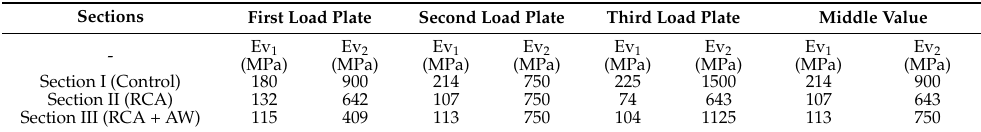
Table 8. Value of plate bearing test for study